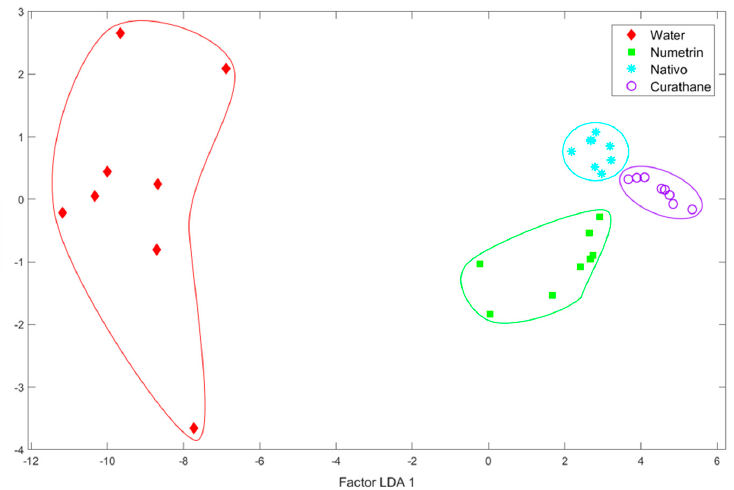
Figure 4. LDA plot using the carbon electrode (C110) to classify Numetrin, Nativo, and Curathane pesticides against distilled water samples.